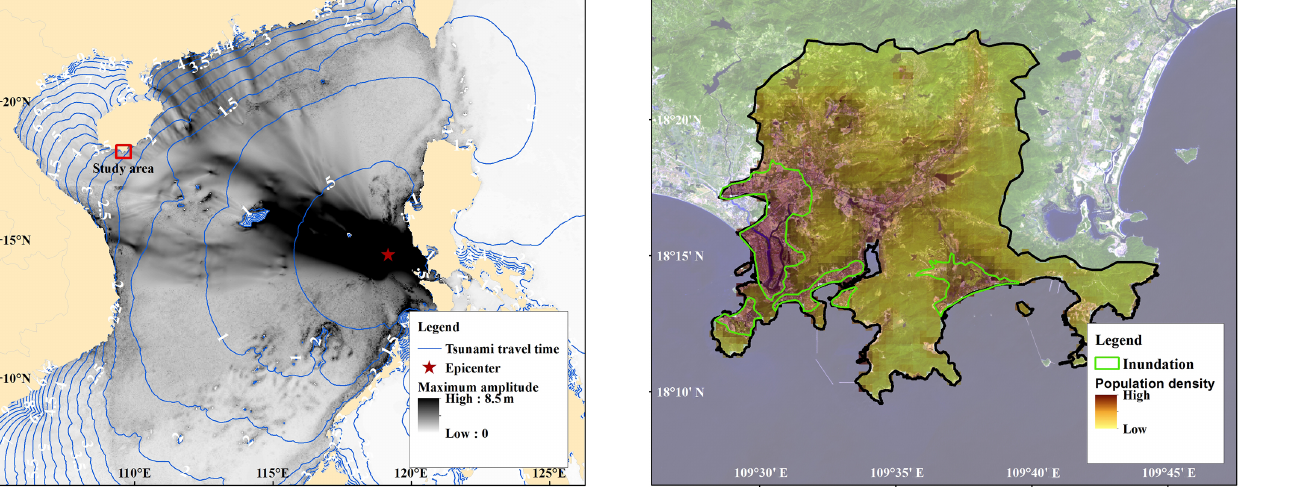
Figure 5. Tsunami travel time and maximum amplitude. Figure 6. Vulnerability map based on population